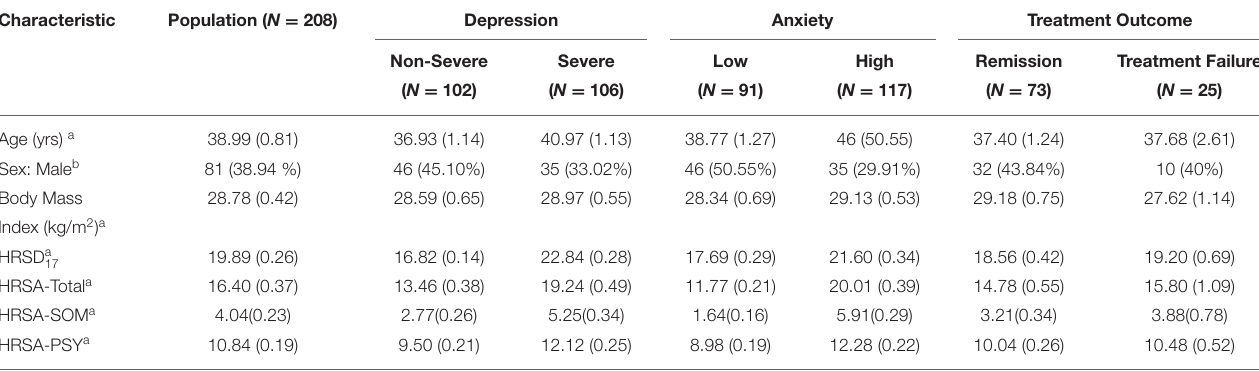
TABLE 1 | Participant demographic and clinical